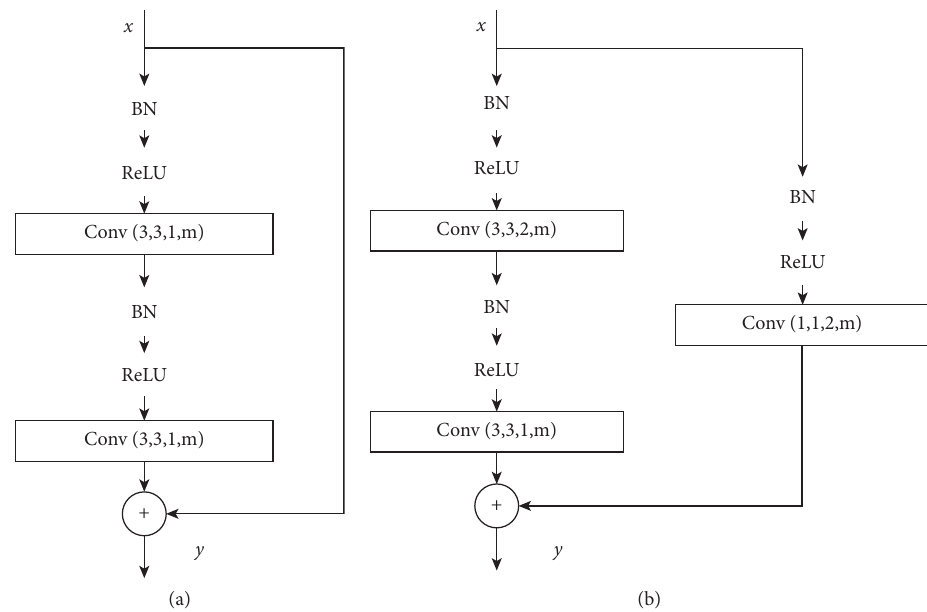
Figure 3: Architectures of two kinds of residual blocks: (a) identity residual block-m (IRB-m) and (b) subsampling residual block-m (SRB- m), where m refers to the number of the convolution